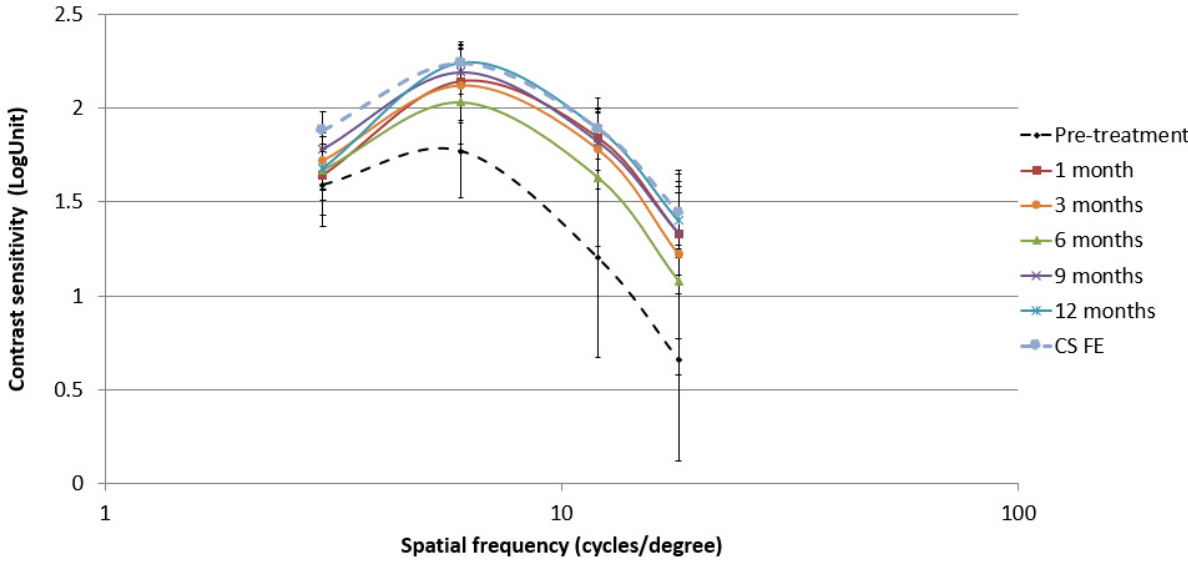
Figure 4. Changes in contrast sensitivity (CS) in the amblyopic eye during the follow-up compared to the baseline values of CS in the fellow eye (FE).